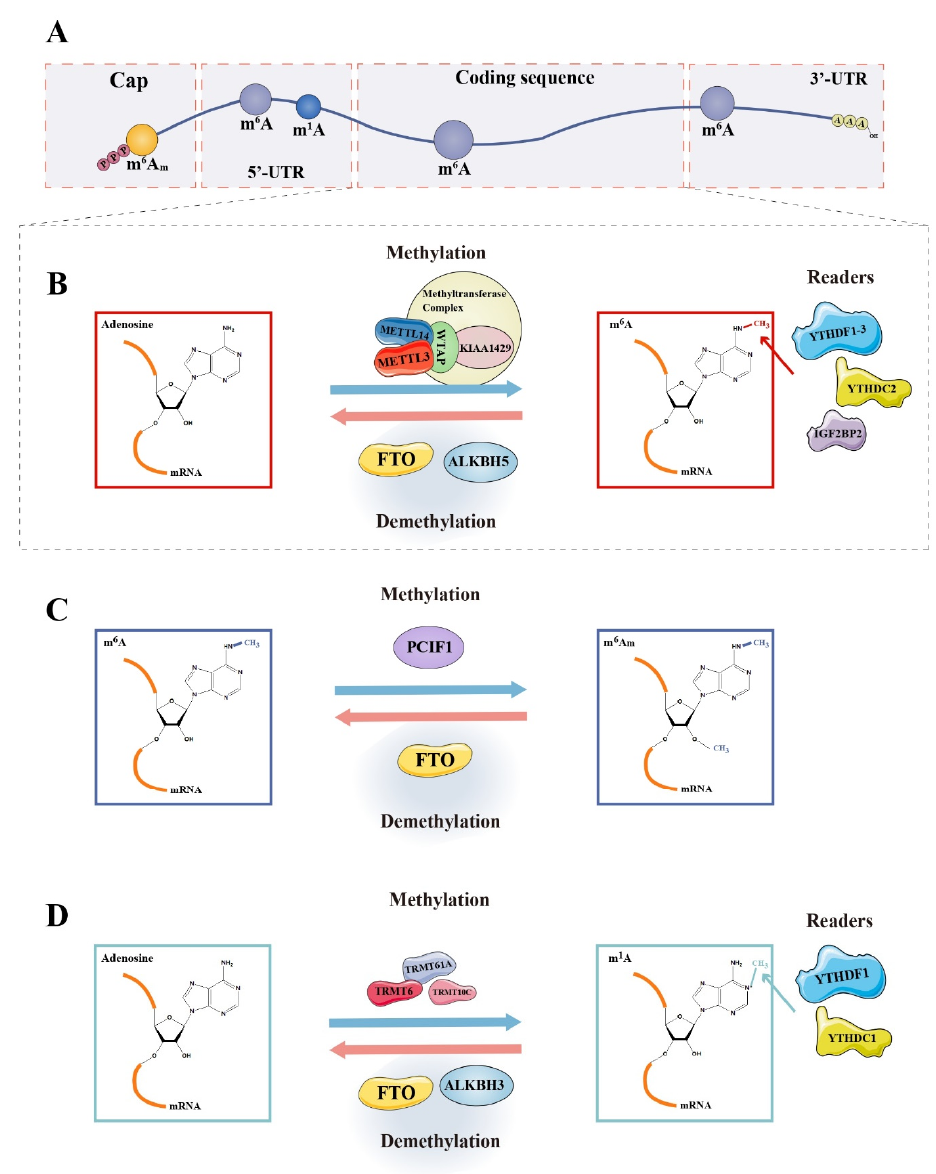
Figure 2. Dynamic changes in methyladenosine modifications on mRNA. ( A ) Distribution of m 6 A, m 1 A, and m 6 A m modifications on mRNA; ( B ) methylases, demethylases, and readers of m 6 A modification; ( C ) methylases, demethylases, and readers of m 6 A m modification; and ( D ) methylases, demethylases, and readers of m 1 A modification. 3. Writers, Erasers, and Readers in the Coregulation of the Dynamic Adjustment of Methyladenosine Modification m 6 A is the most common type of reversible methyladenosine modification in mRNA [24] and has been a hot topic in epigenetic research for decades. Methylation or demeth ‐